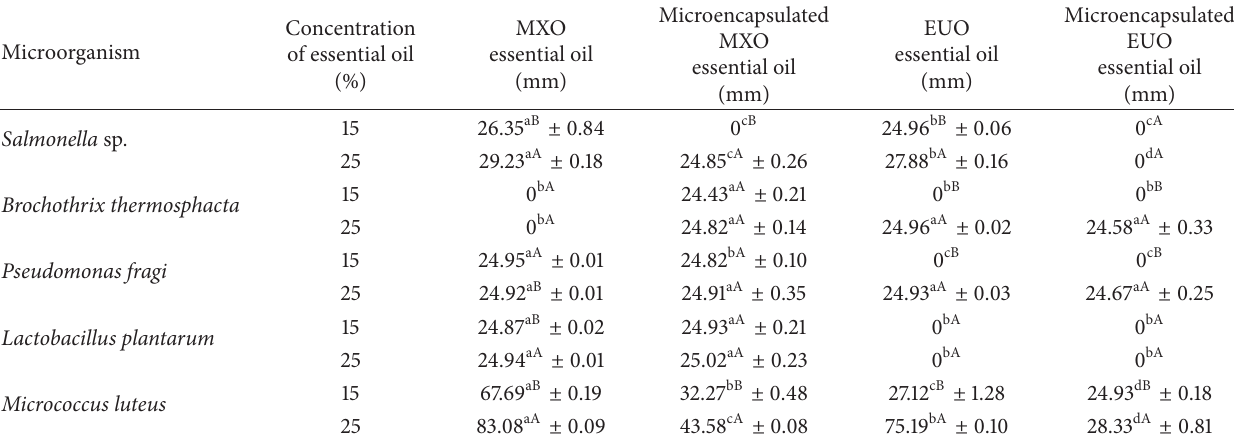
Table 5: Inhibition zone diameters obtained with Lippia graveolens H.B.K. and Origanum vulgare L. essential oils at 15% and 25% (w/v) concentration against test organisms.